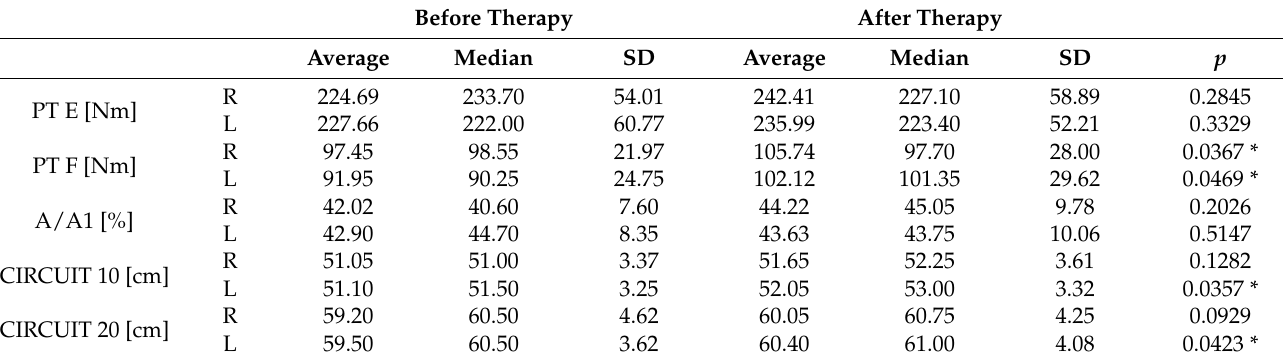
Table 2. Descriptive statistics and the statistical significance of the differences registered between the analysed parameters before and after therapy in the study group treated using the RSQ1